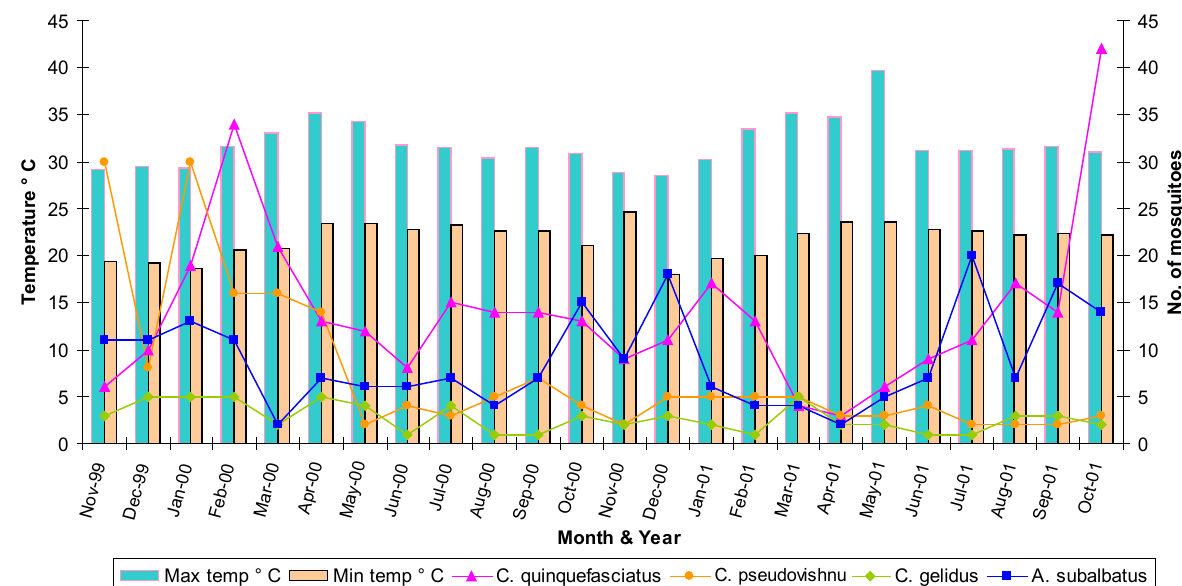
FIGURE - 2 Figure 1. Population dynamics of mosquito species in relation to temperature (maximum and minimum) in North POPULATION DYNAMICS OF MOSQUITO SPECIES IN RELATION TO Coimbatore POPULATION DYNAMICS OF MOSQUITO SPECIES IN RELATION TO HUMIDITY IN NORTH TEMPERATURE IN NORTH COIMBATORE